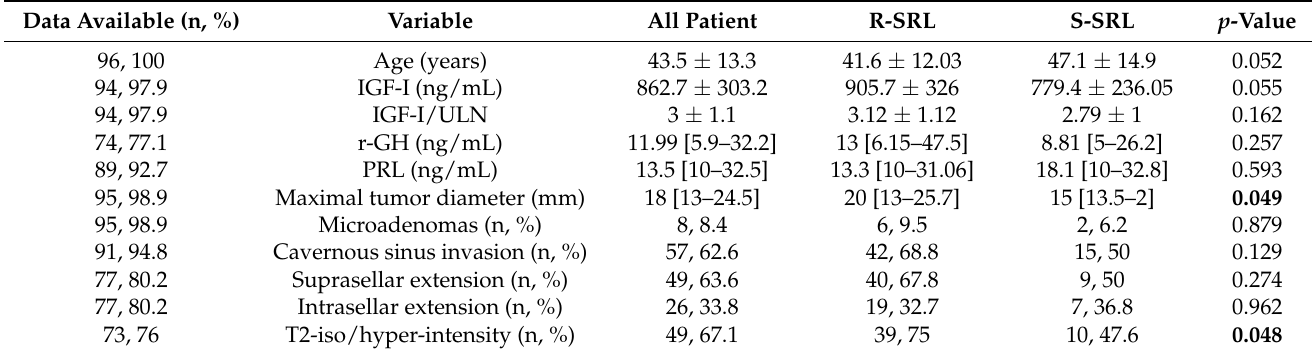
Table 2. Clinical, biochemical and MRI radiological features at